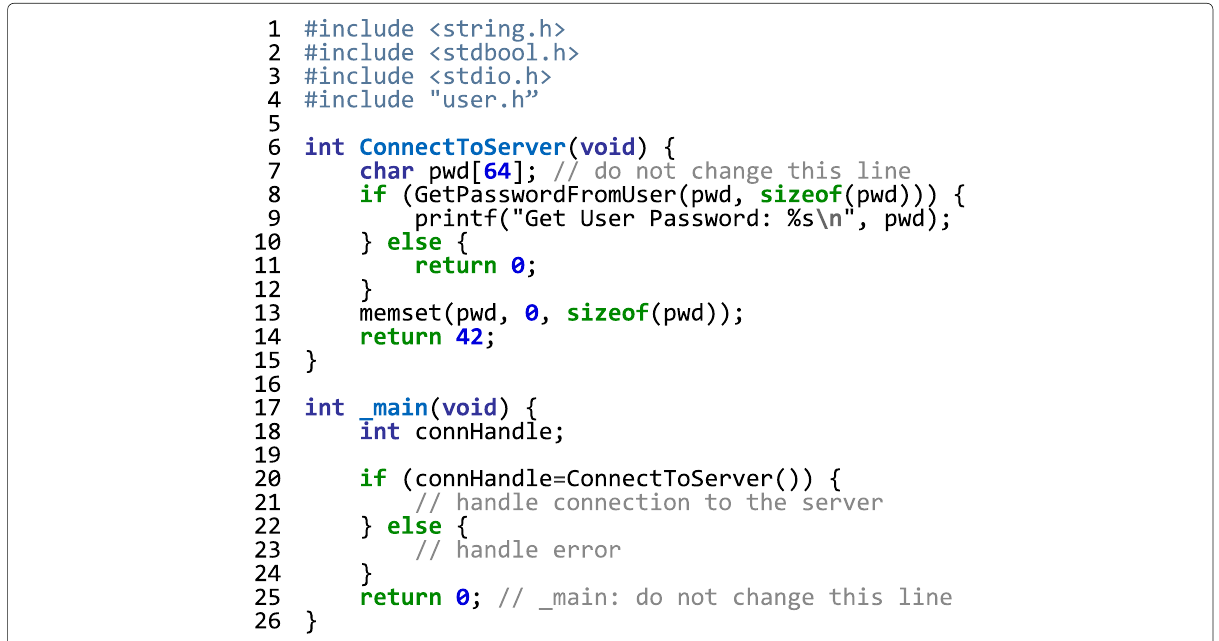
Fig. 10 Project Code for CWE-14